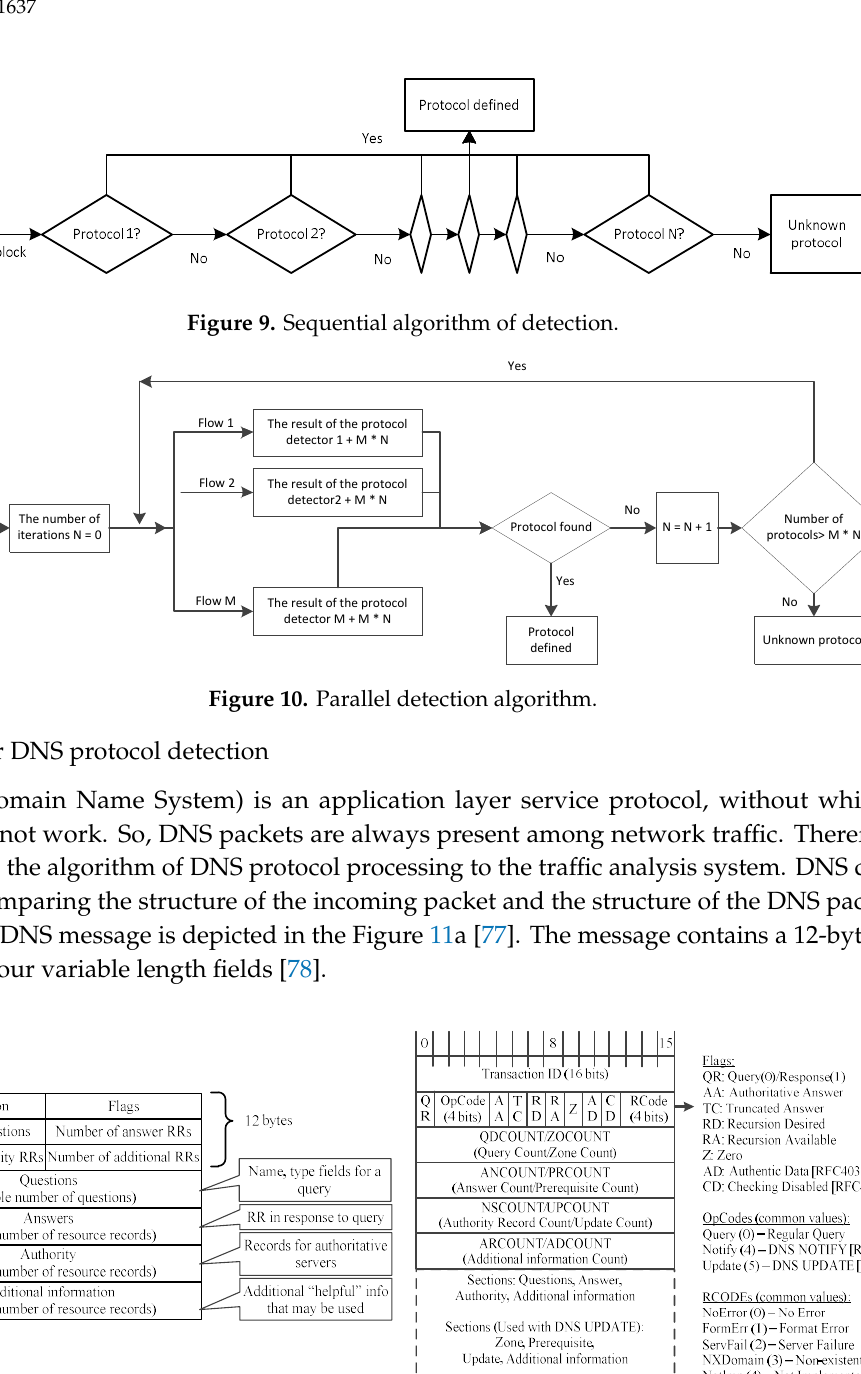
Figure 9. Sequential algorithm of detection.